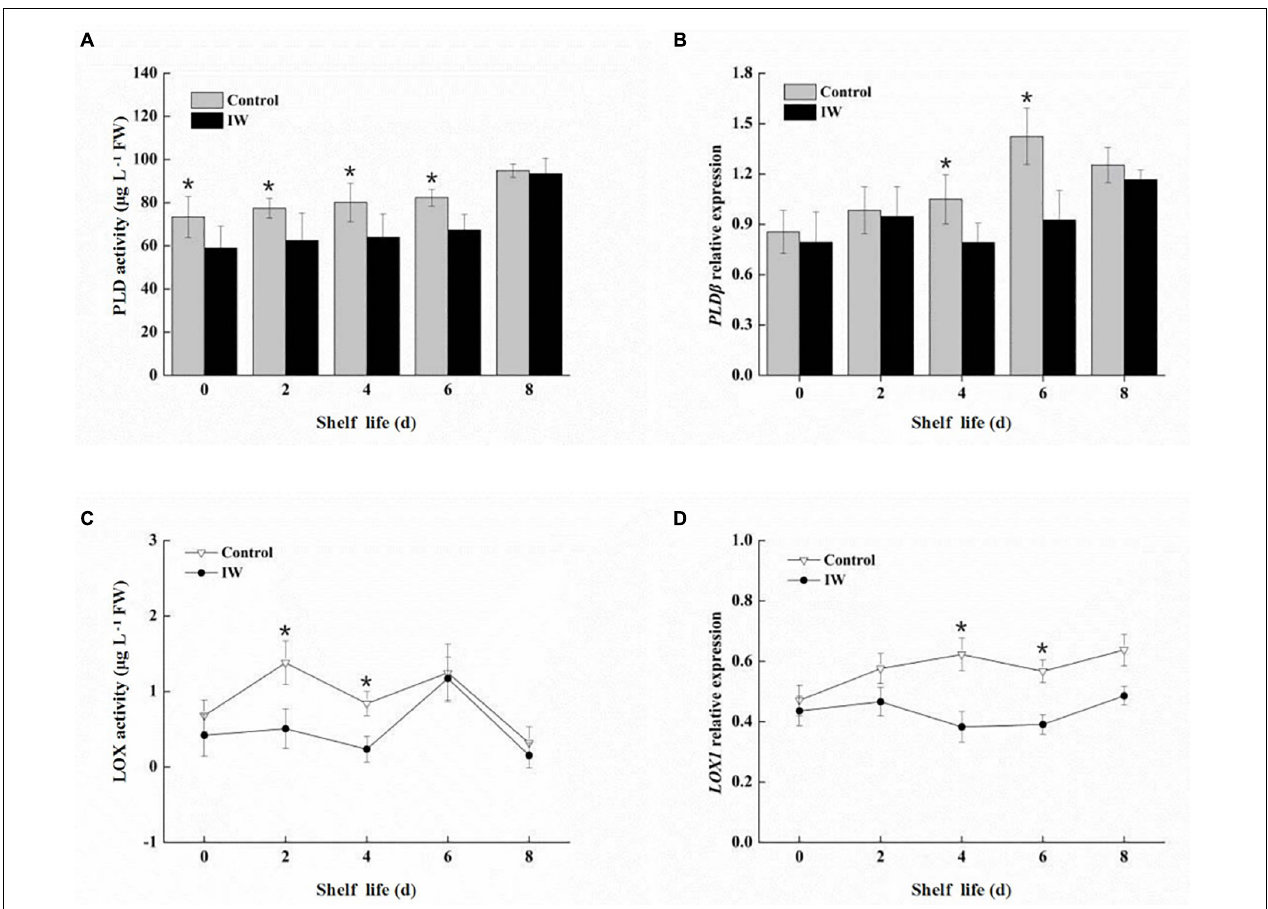
FIGURE 5 | Effect of intermittent warming on PLD activity (A) , gene expression of VcPLD β (B) , LOX activity (C) , and gene expression of VcLOX1 (D) in blueberry fruit at room temperature after a 30-day refrigeration. Mean ± SE of three replicate experiments are shown. Asterisks indicate significant differences between control and IW-treated fruit ( *p <